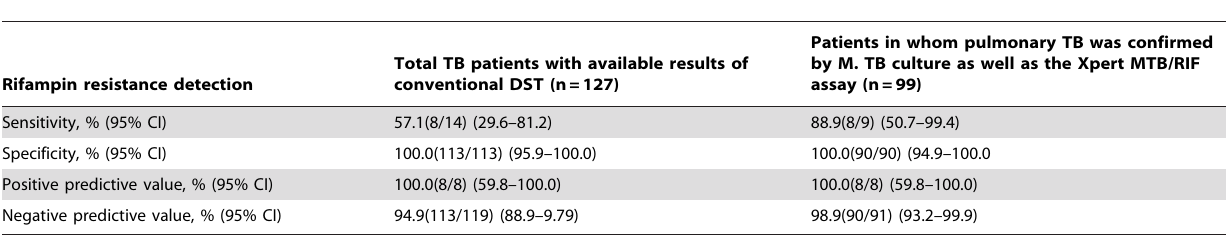
Table 4. Diagnostic accuracy of the Xpert MTB/RIF assay using sputum specimens to detect rifampicin resistance among bacteriologically confirmed pulmonary tuberculosis in whom conventional DST results were available.